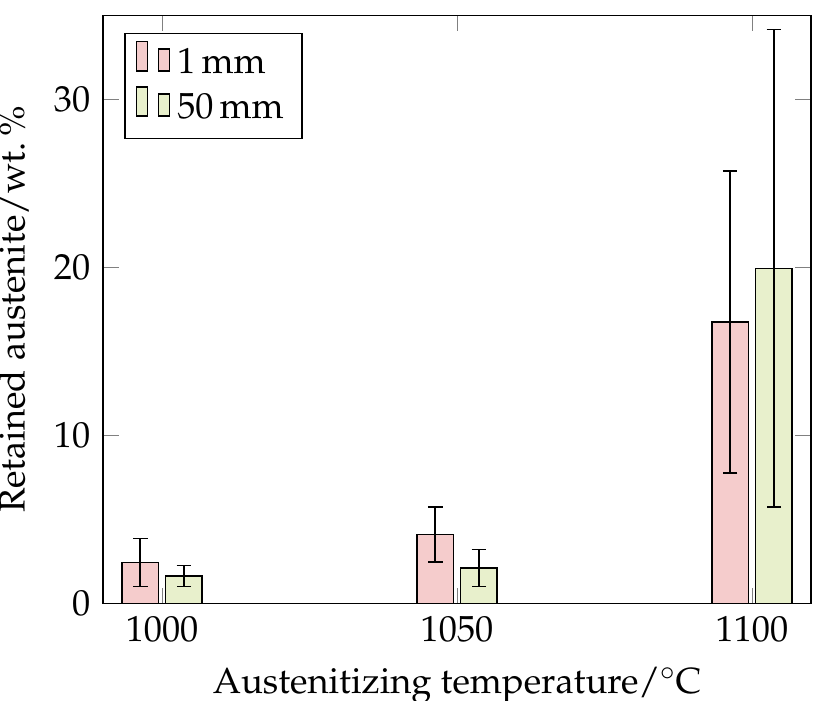
Figure 20. Retained austenite measured by XRD. At 1000°C and 1050°C the mean values are shown with the respective minimum and maximum values. Note that a mass fraction of 1% is the detection limit. Due to larger variations at 1100°C, a total of eight measurements, each at 1mm and 50mm, were carried out by XRD. In this case, the mean values and the standard deviation are presented.